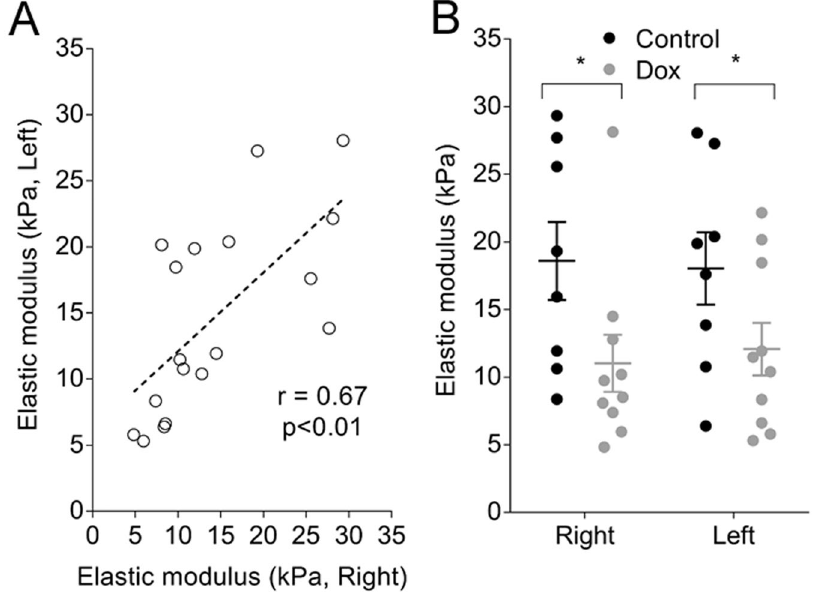
Figure 4. Elastic modulus of mouse diaphragm measured by OCT-based indentation. Right and left lateral measurements (data are from Control and Dox groups combined) were positively correlated ( A , n = 18). Elastic modulus of diaphragm from the Dox group was reduced compared with the Control group ( B ). There was no effect of location. Data are mean ± SE. * p <